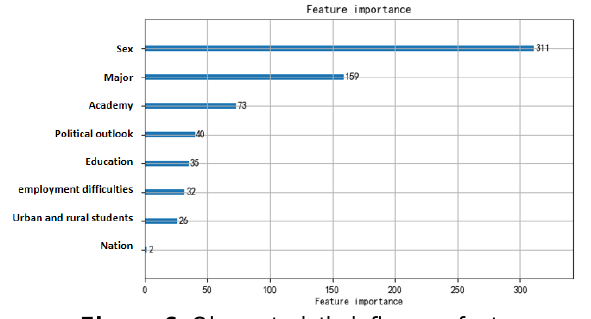
Figure 6. Characteristic influence factor